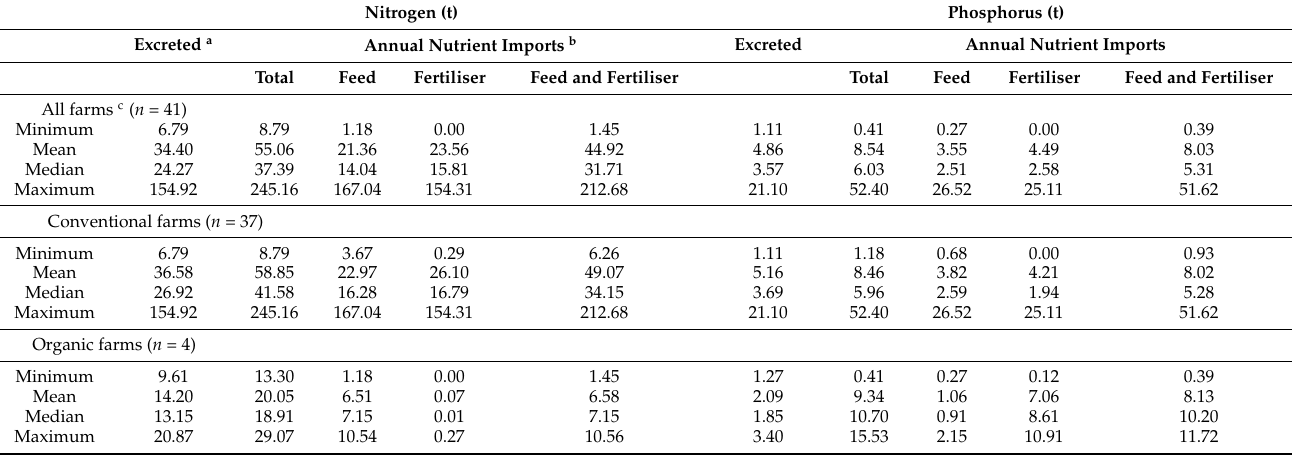
Table 5. Calculated annual Nitrogen, Phosphorus, Potassium, Sulphur, Calcium, and Magnesium (t) excreted by the lactating herds, total annual nutrient imports and nutrients brought onto the farm in feed, in fertiliser or in both feed and fertiliser, for 41 grazing system conventional and organic dairy farms for which data were